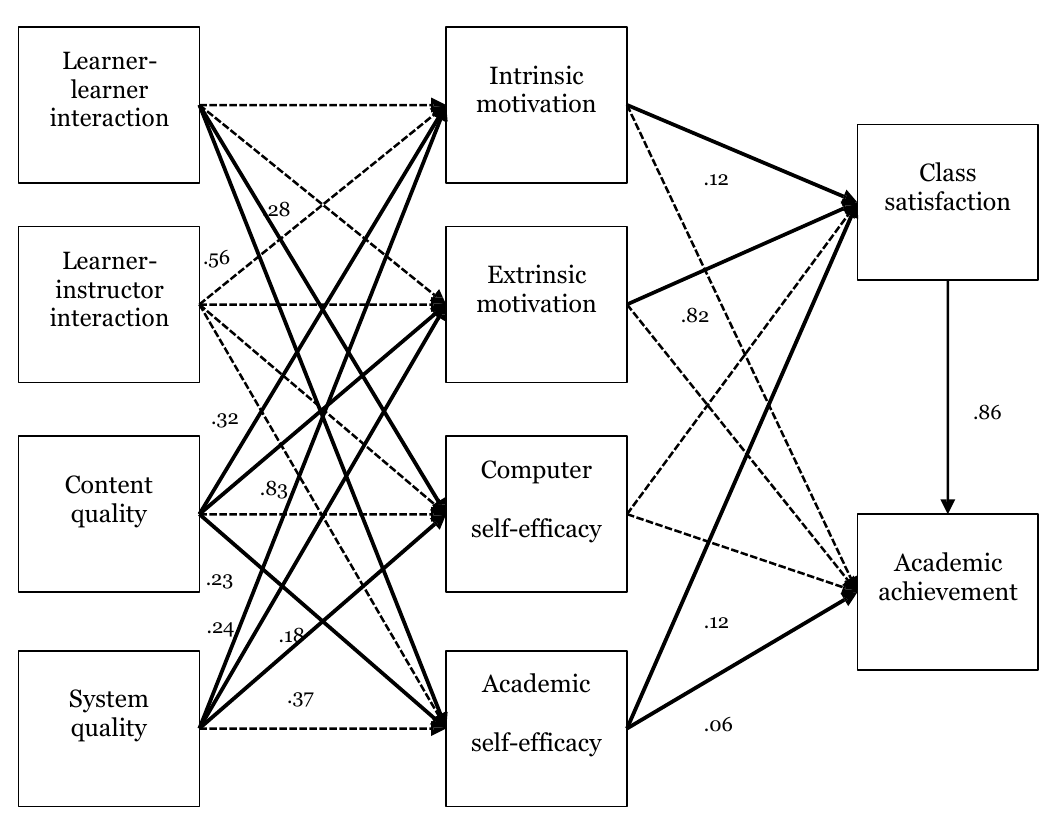
Figure 1 . Standardized path coefficients for the modified